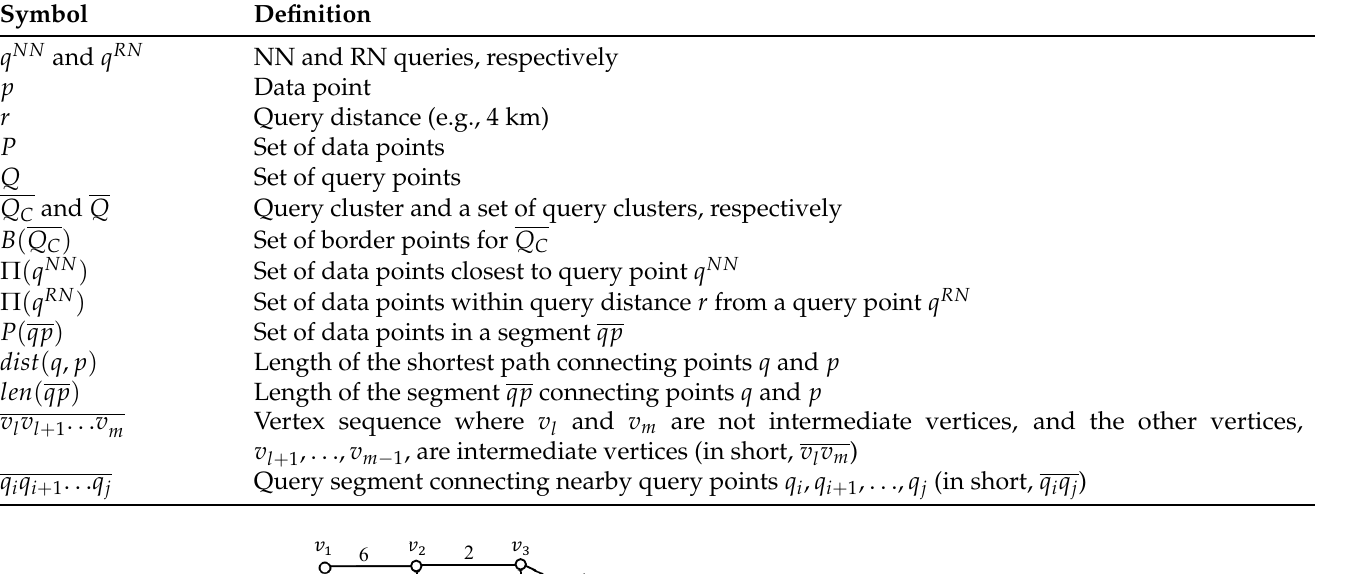
Table 1. Definitions of symbols.